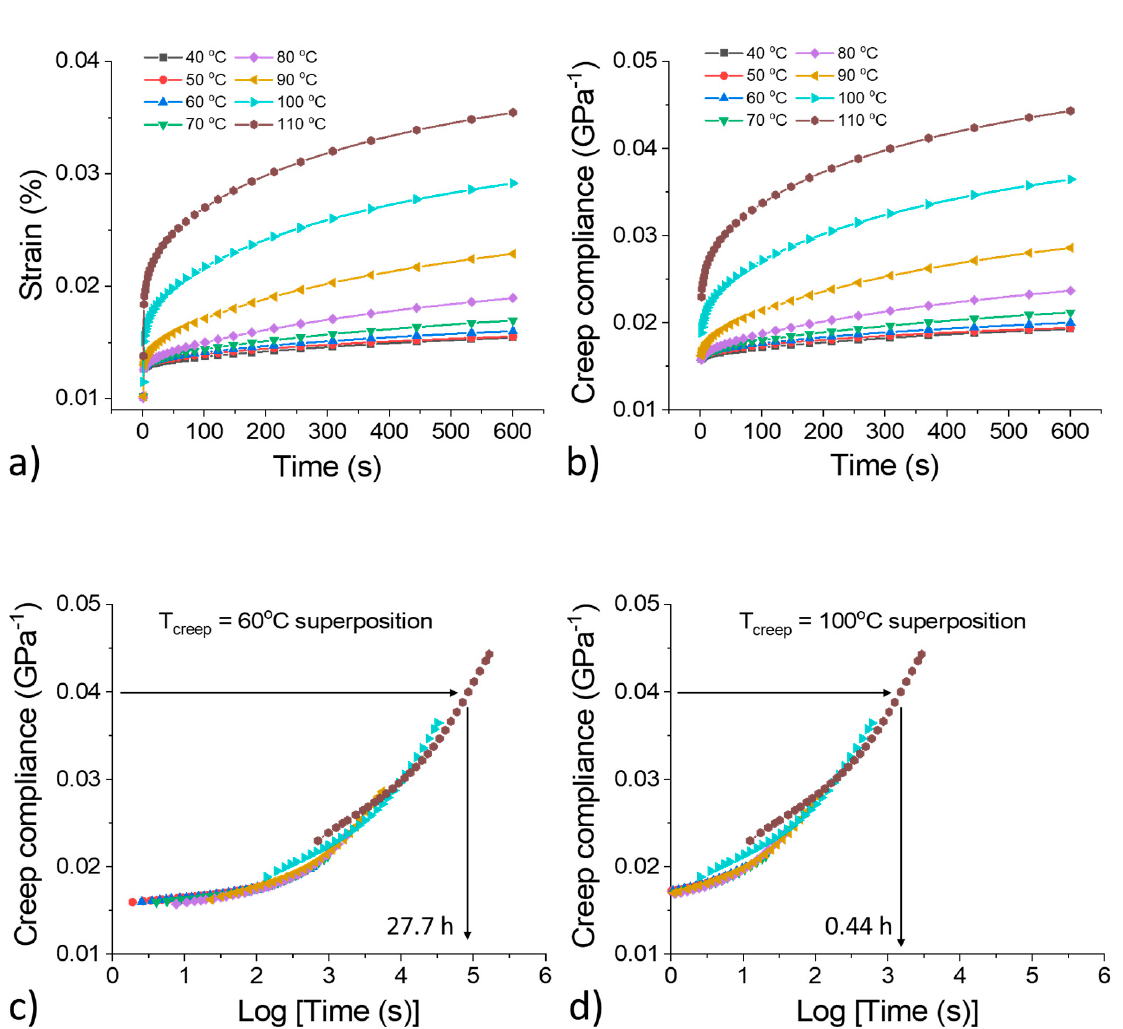
Figure 8. Creep behavior of the polymer composite. ( a , b ) Time-dependent creep strain and creep compliance at different temperature intervals. ( c , d ) Master curves generated from manually shifted creep compliance data based on a time–temperature superposition principle, which predicts the long-term performance of the material.